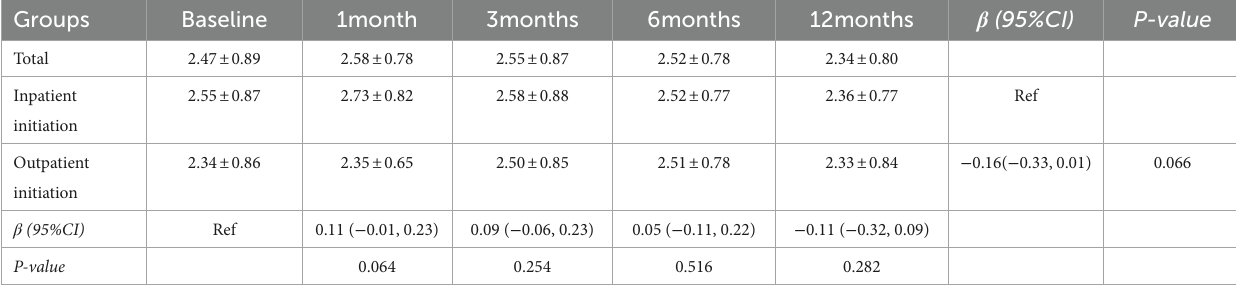
TABLE 3 Comparison of the blood ketone body in the different groups and follow-up times based on the GEE.